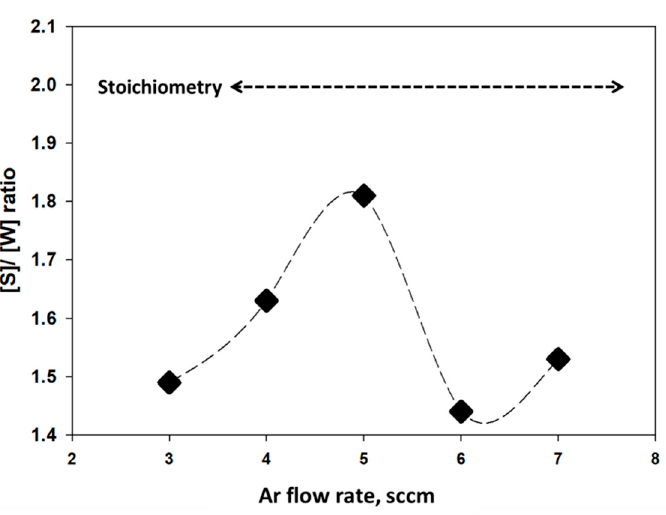
Figure 12. S/W ratio in as-grown WS 2 under different Ar gas flow rates .